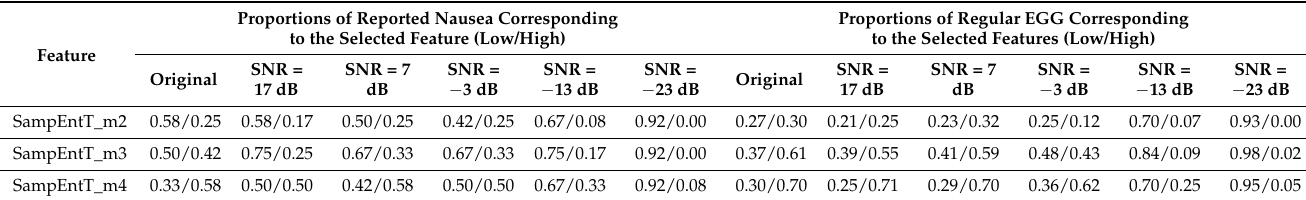
Table 6. Summary statistics for categorical data. For more information, please see Materials and Methods section. SNR stands for Signal-to-Noise